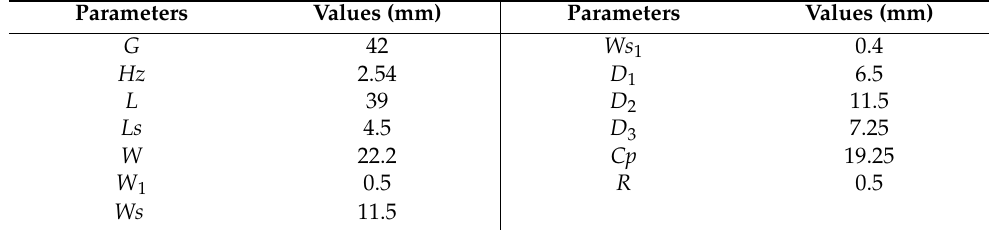
Figure 1. Schematic of proposed wideband PIFA: ( a ) 3-D geometry of the proposed antenna; ( b ) top view; ( c ) side view. Table 1. The detailed dimensions of the proposed antenna.